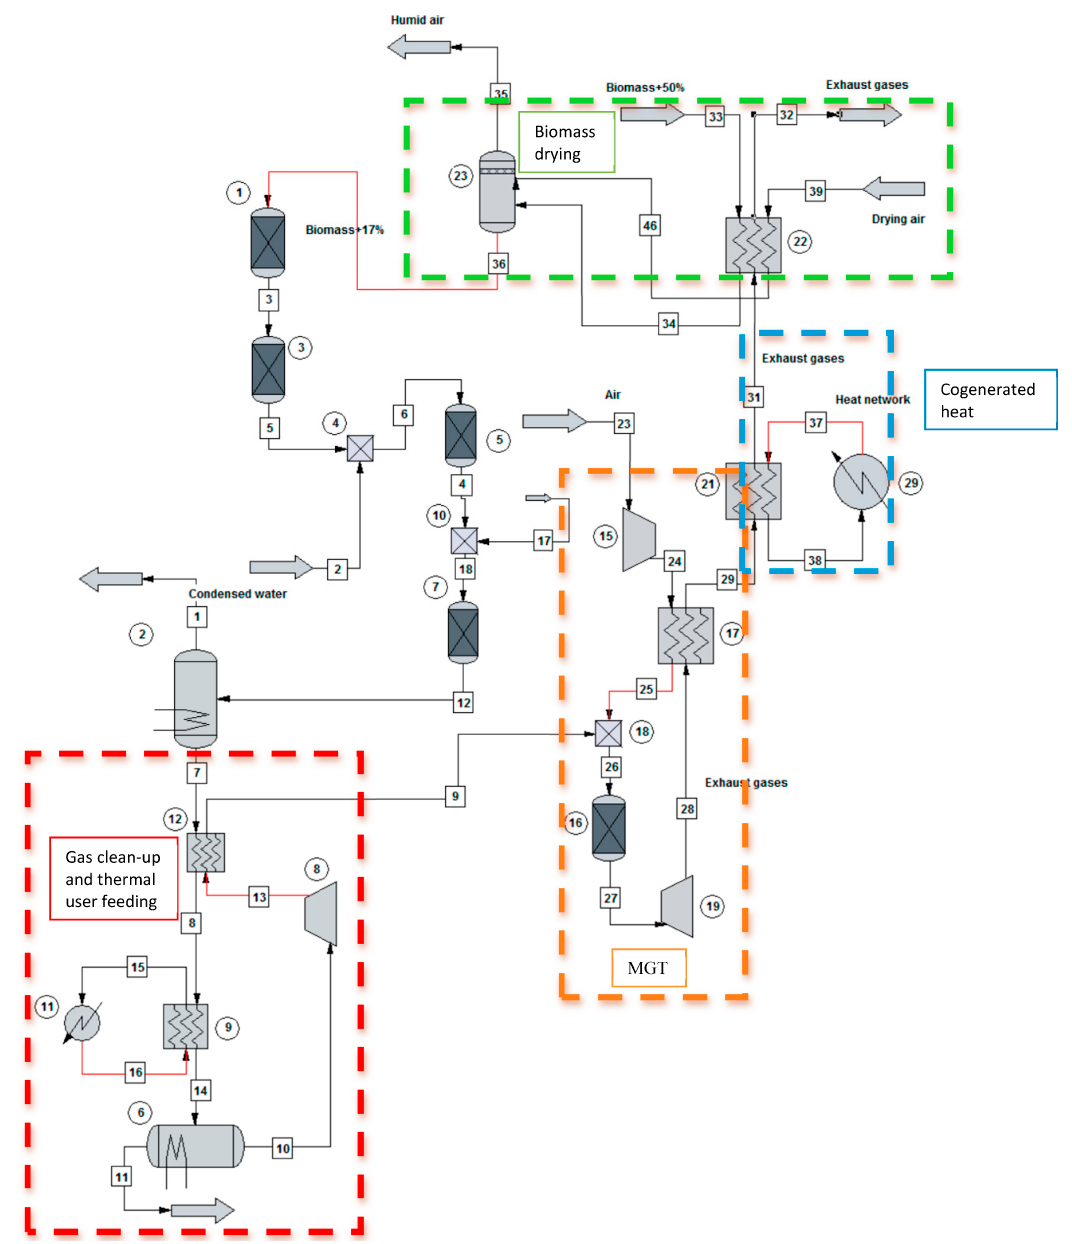
Figure 1. ChemCad layout. Legend of components (circles): 1. Tar Separation; 2. Cyclone; 3.